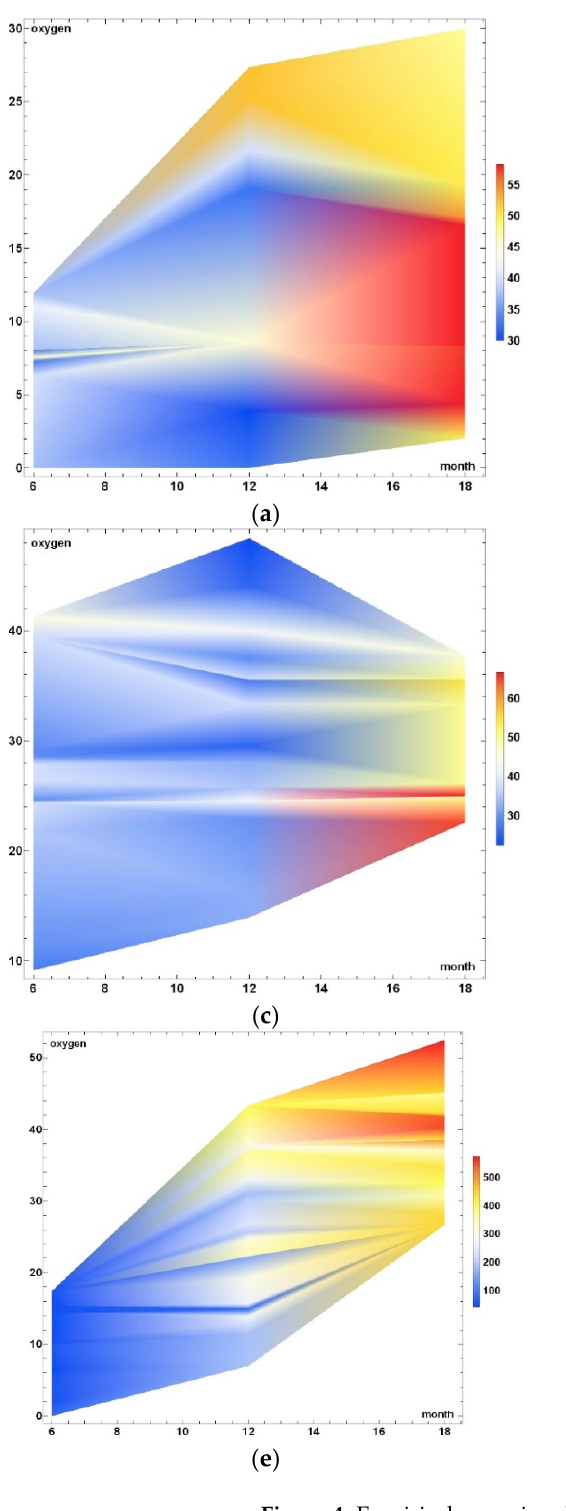
Figure 4. Empirical corrosion depth: Influenced by air on NiTi1 ( a ) and NiTi2 alloys ( b ), influenced by the tide on NiTi1 ( c ) and NiTi2 alloys ( d ), influenced by sea on NiTi1 ( e ) and NiTi2 alloys ( f